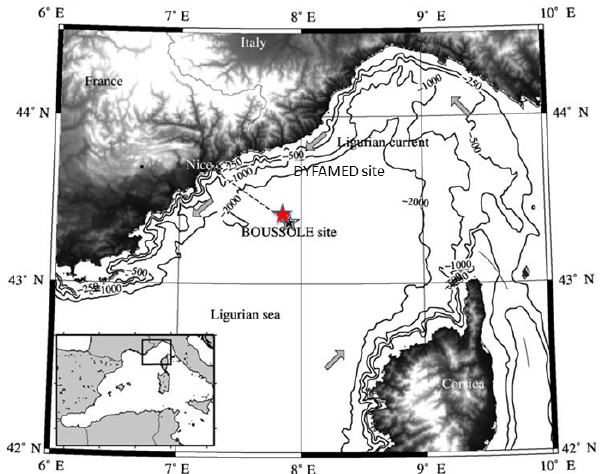
Figure 1. The area of the northwestern Mediterranean Sea show- ing the southern coast of France, the Island of Corsica, the main current branches (gray arrows), the location of the DYFAMED site (43 ◦ 25 (cid:48) N, 7 ◦ 52 (cid:48) E, red star) (http://doi.org/10.17882/43749, last access: 14 September 2018) and the BOUSSOLE buoy (43 ◦ 22 (cid:48) N, 7 ◦ 54 (cid:48) E, black star) in the Ligurian